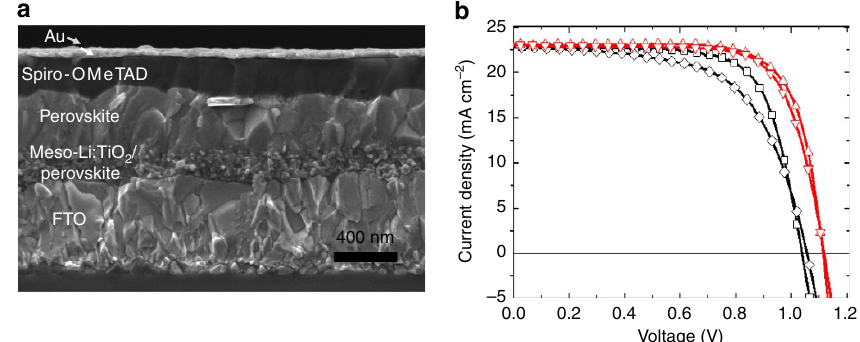
Figure 4 | Morphology and J – V curves of the solar cells. ( a ) SEM cross-sectional image of the device. ( b ) Current density–voltage curves of the solar cells with and without the Li þ doping (red and black curve, respectively) collected under AM1.5 simulated sun light. Devices were masked with a black metal aperture of 0.16cm 2 to define the active area. The curves were recorded scanning at 0.01Vs -1 from forward bias to short circuit condition and vice versa with no device preconditioning such as light soaking or holding at forward voltage bias. Legend: black diamond, control forward scan; black square, control reverse scan; red down-pointing triangle, Li þ -doped forward scan; red up-pointing triangle, Li þ -doped reverse scan.